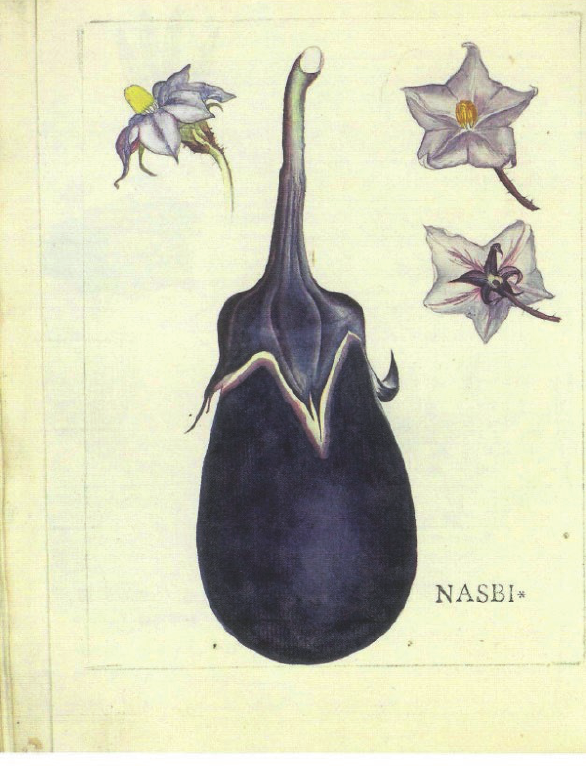
Figure 13. Udagawa Youan’s eggplant painting (Endo et al. 2014, p. 611) (Photo courtesy of Takeda Science